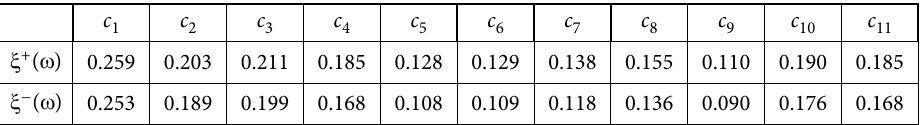
Table 4. Transformed probability weights